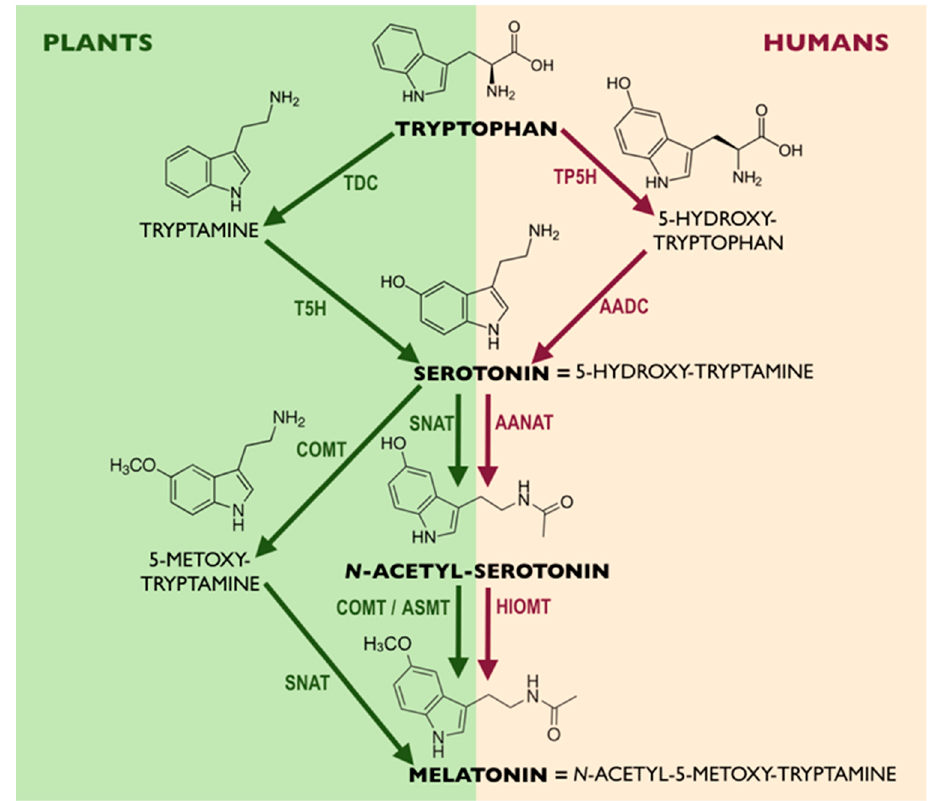
Figure 3. Comparison of melatonin biosynthetic pathways in plants and humans. AADC, aromatic- L -amino-acid decarboxylase; AANAT, arylalkylamine N-acetyltransferase; ASMT, N-acetylserotonin